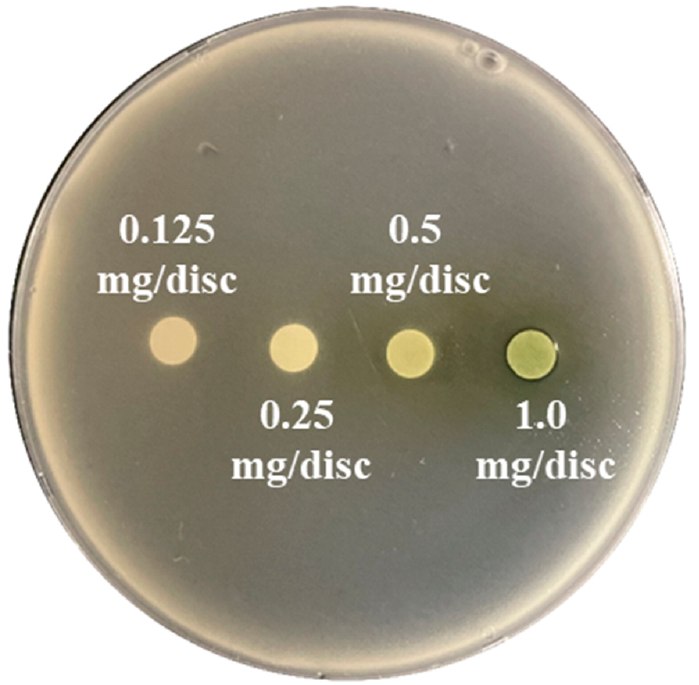
Figure 2. Representative image showing antibacterial activity of A . rugosa hairy roots cultured with sucrose against B . cereus . Table 4. Antibacterial activity of methanol extracts of A . rugosa hairy root cultured with sucrose and fructose .